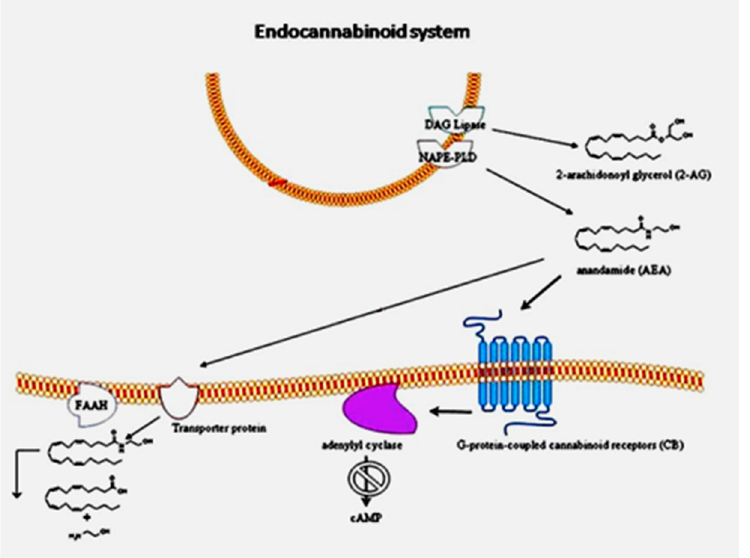
Figure 1. Endocannabinoid system workflow in peripheral blood mononuclear cells of patients with autism spectrum disorder (ASD). The cannabinoid receptor 2 (CB2) gene is over-expressed, as well as protein levels. The anandamide synthesis enzyme N -acyl phosphatidylethanolamine-specific phospholipase D (NAPE-PLD) gene is slightly decreased. Reprinted from [7], with permission from Springer (Berlin/Heidelberg, Germany) (license #5034221089815).